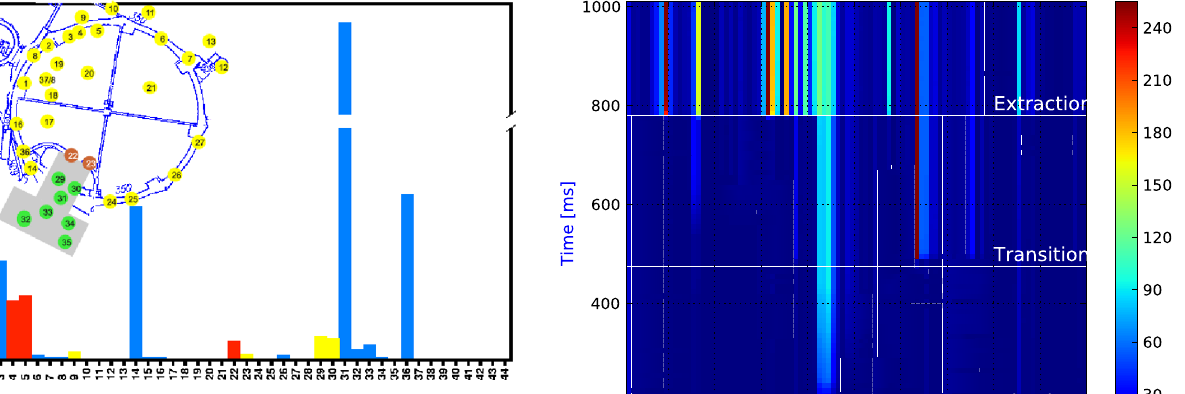
FIG. 1. Result of the 2006 PS radiation survey in (cid:2) Sv = h for a circulating intensity of 0 : 8 (cid:1) 10 13 p þ = sec [2]. Measurements were taken from 44 different stations spread all along the PS tunnel (top left). The color code in the histogram represents the ratio between the measured dose and the guideline value speci- fied in [15]. In blue, stations where the dose is below 30% of the guideline value; in yellow, stations where the measured dose is between 30 and 100%; in red, where the measured dose is above 100%. The stations measuring in building 151 are 22–23 (brown) and 29–35